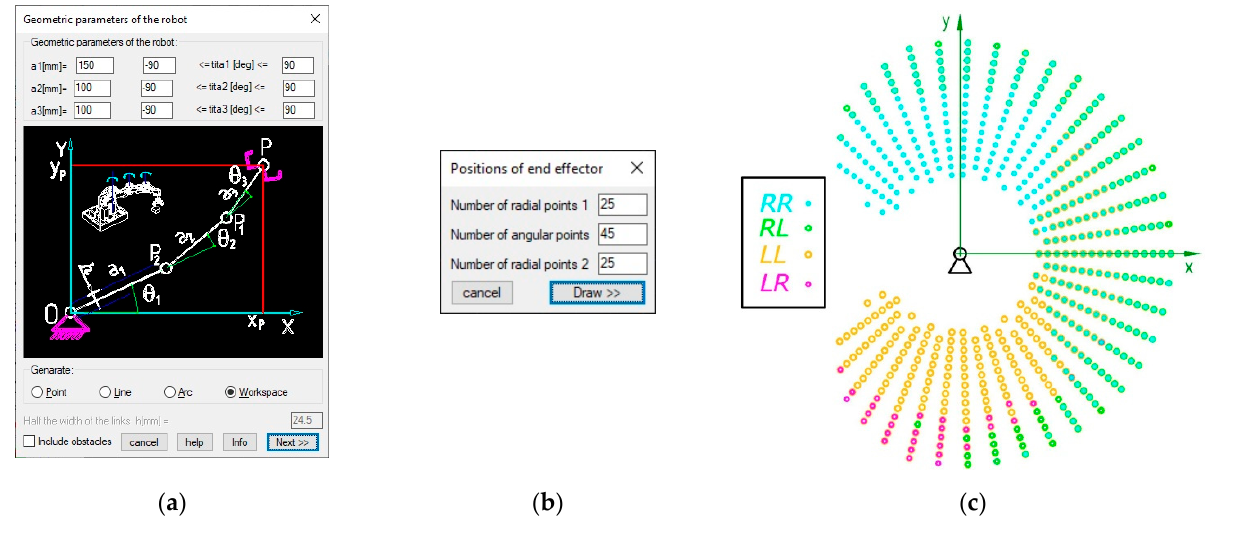
Figure 15. ( a ) Dialog window for setting the basic geometrical parameters of the robot. ( b ) Dialog window for generating points in polar coordinates. ( c ) Generated workspace divided by type of available solutions.